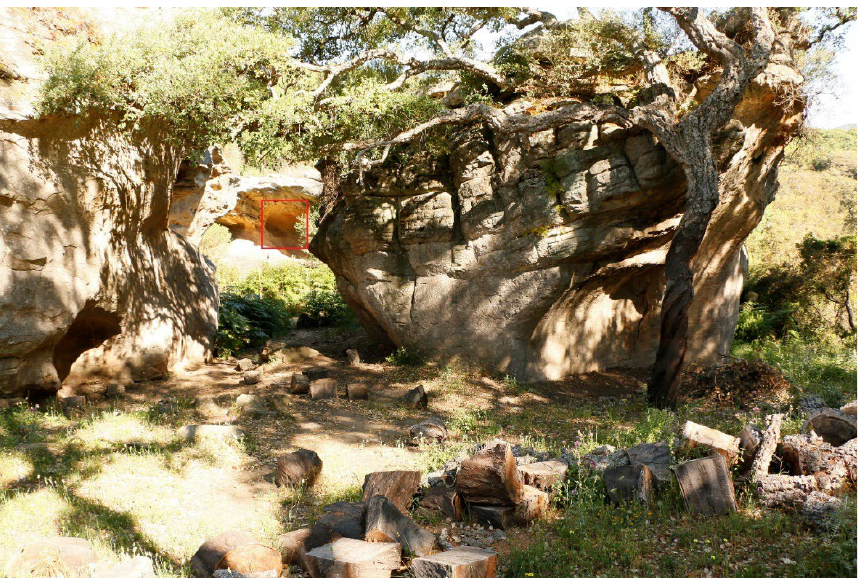
Figure 2. General view of Bacinete main shelter. The red frame indicates the location of the rock art panels. Photographs by N. Santos da Rosa, Artsoundscapes project, 2021.